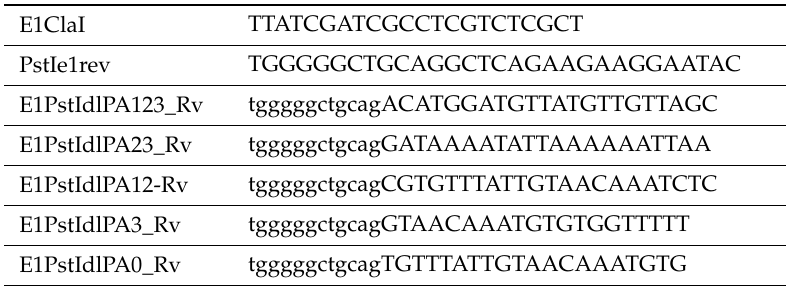
Table 1. Primers used for mutating poly(A) cluster at the end of the M112-113 gene. E1ClaI